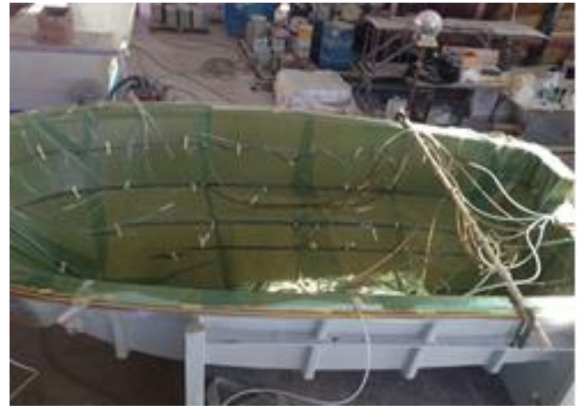
Figure 16. RTM process of laminate